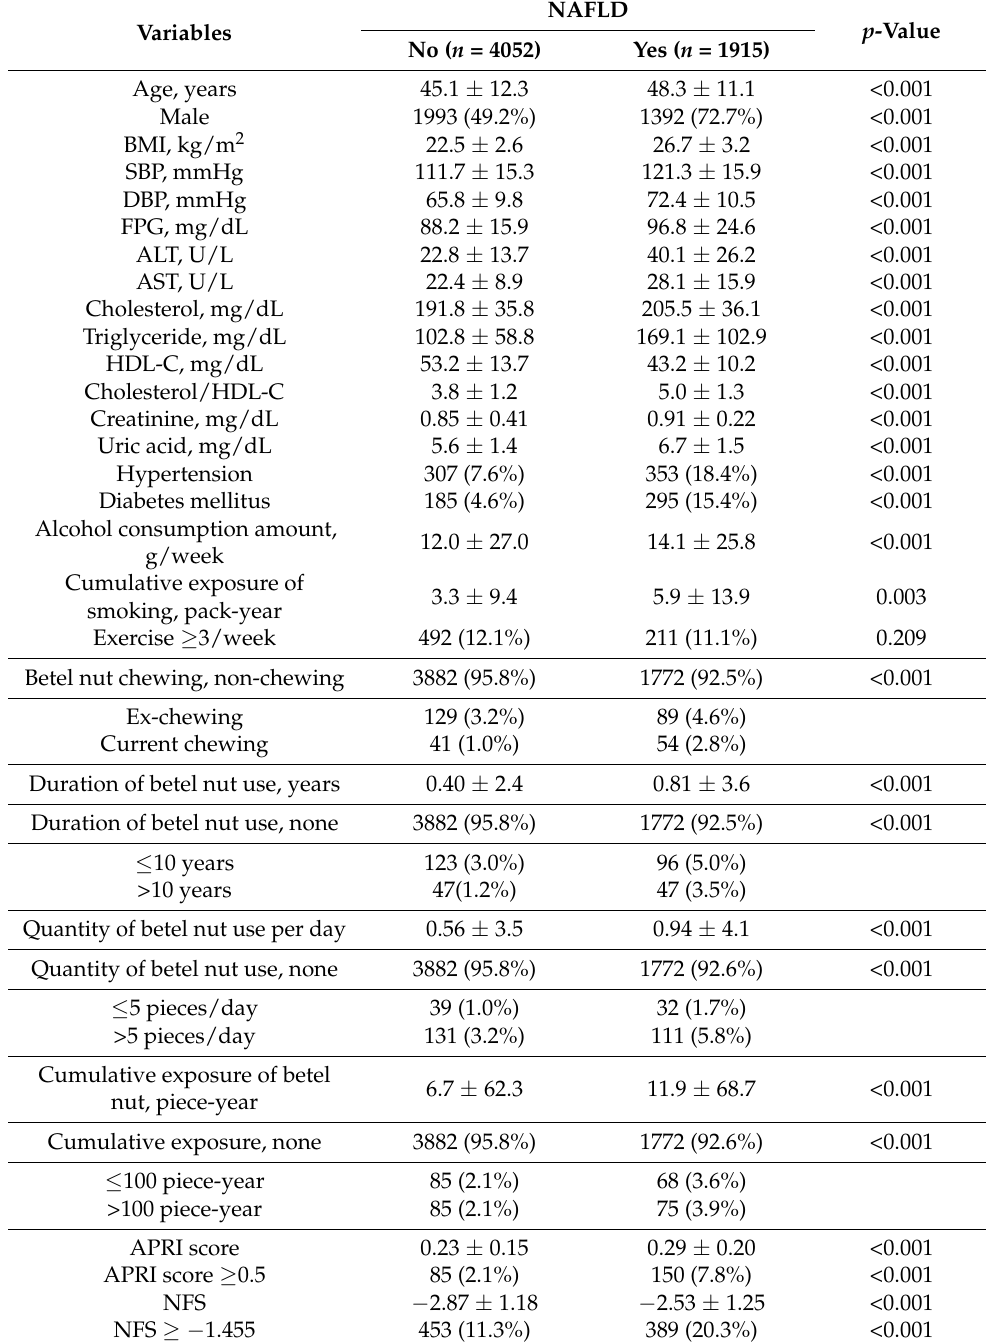
Table 1. Comparisons of participants’ clinical characteristics between subjects with and without nonalcoholic fatty liver disease